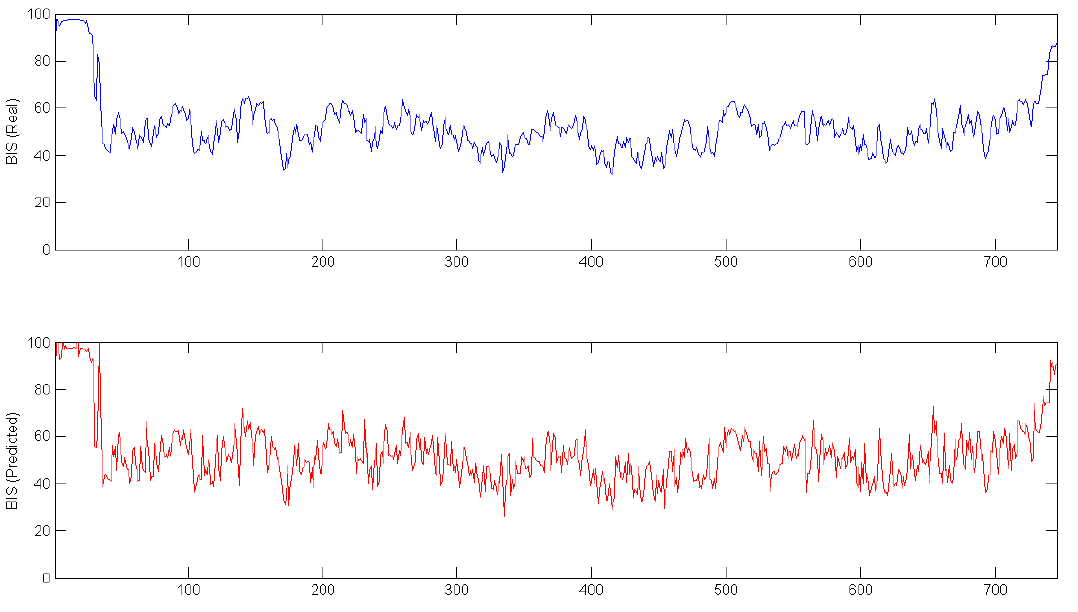
Figure 6. Real ( Top ); and predicted ( Bottom ) BIS signal for one complete